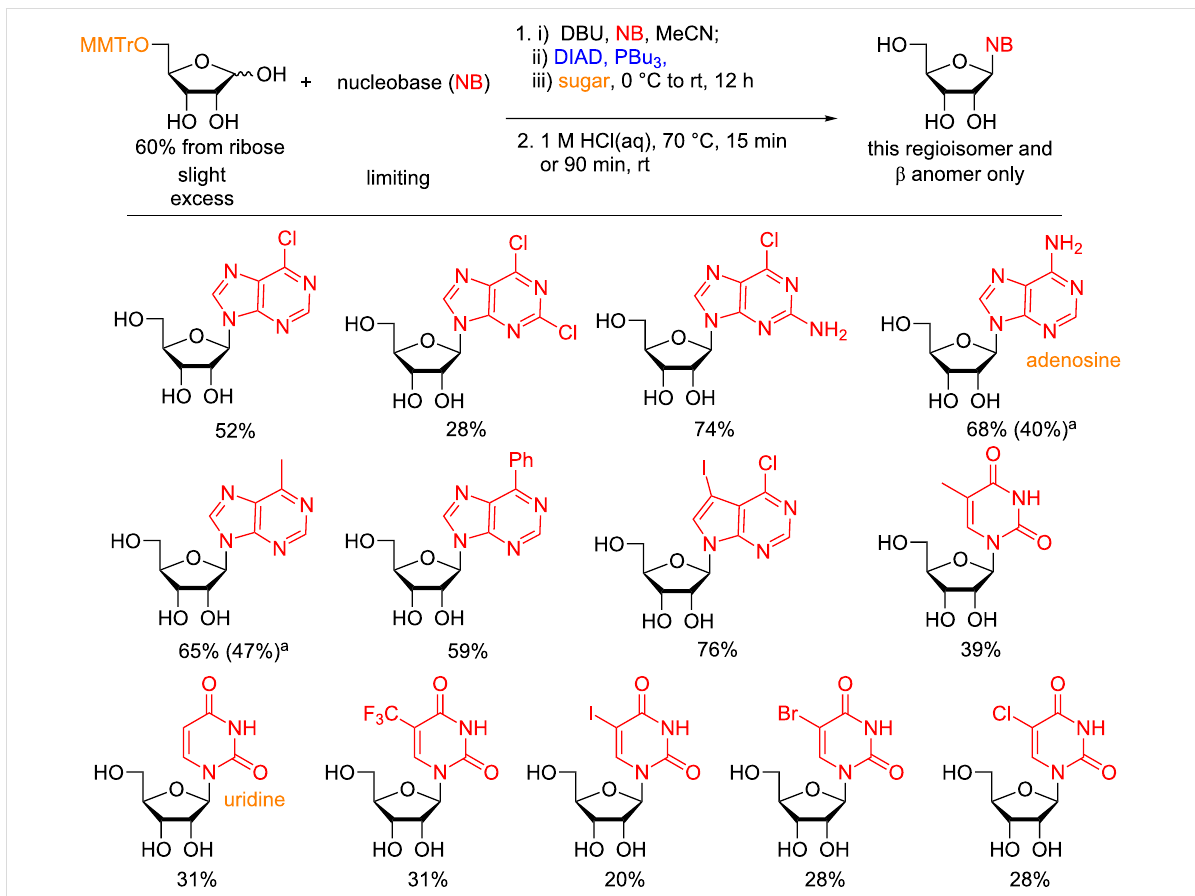
Figure 10: Direct synthesis of furanosyl nucleosides from 5- O -monoprotected ribose in a one-pot glycosylation–deprotection strategy. a Yield in paren- theses is after crystallization from MeOH due to trace impurities still present after chromatographical purification. DIAD = diisopropyl azodicarboxylate.